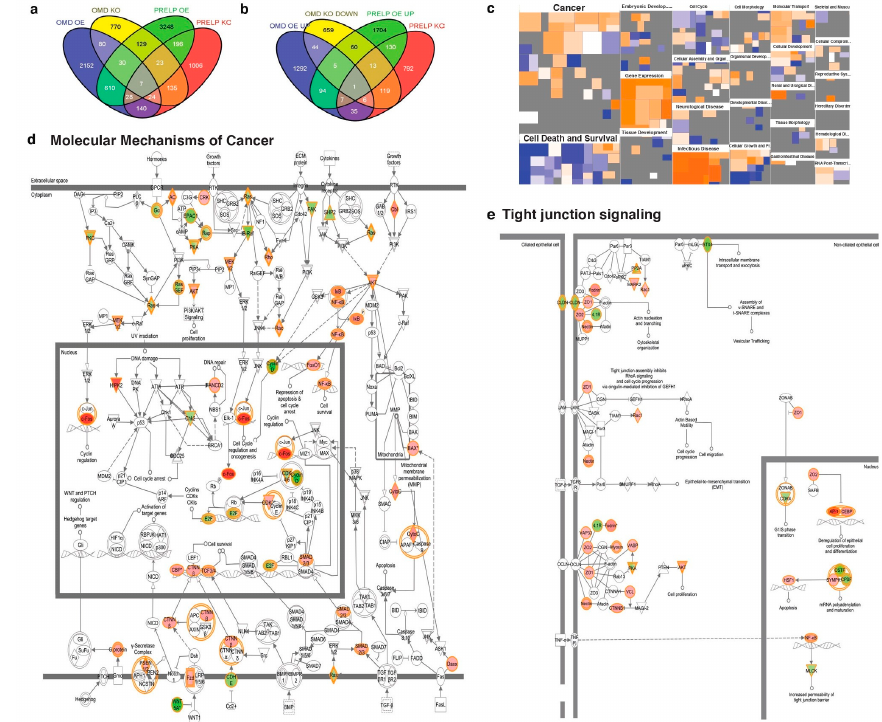
Figure 2. Gene expression profiling in OMD/PRELP overexpressing or deleted cells. Gene